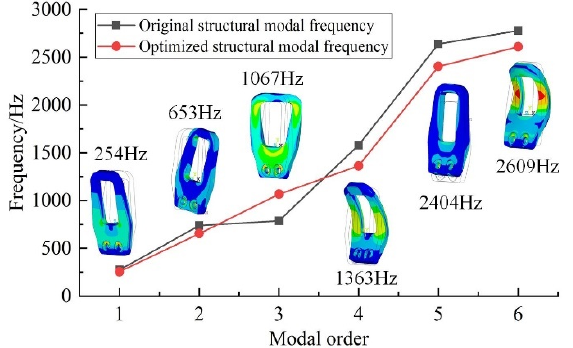
Figure 22. Modal comparison of the wheelset lifting mechanism before and after optimization.